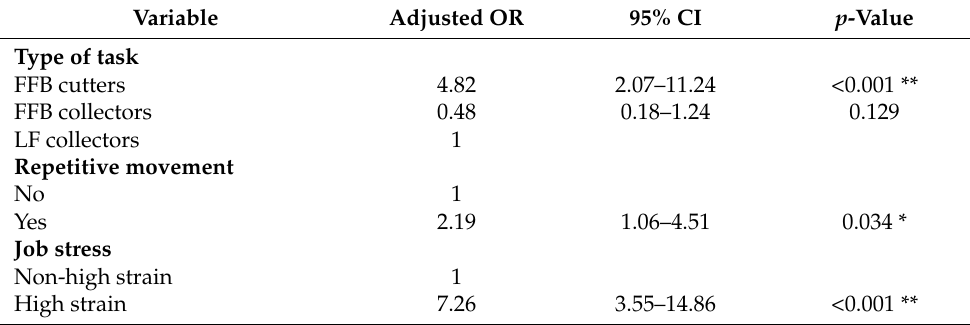
Table 6. Multivariate analysis of neck MSDs during the past 12